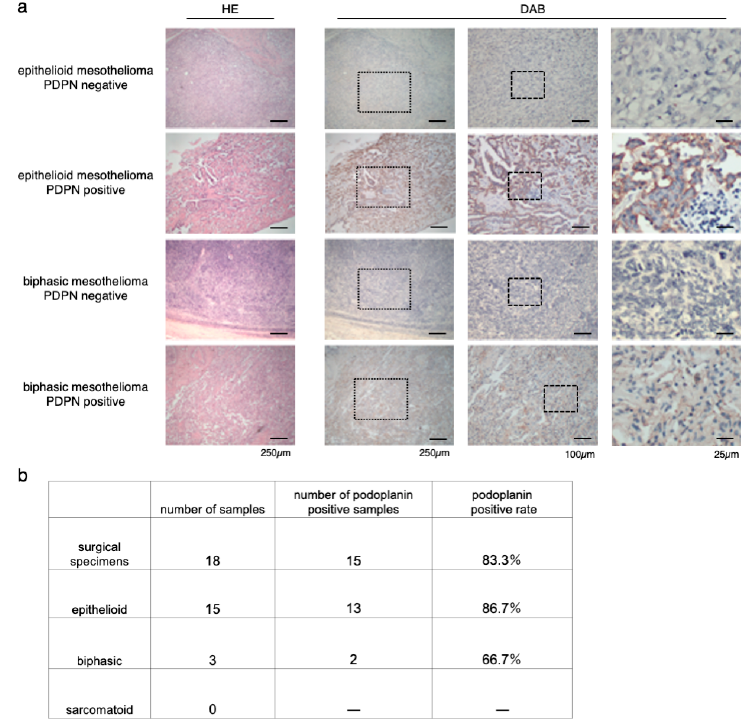
Figure 1. Immunostaining of surgical specimens of human resected MPM (malignant pleural mesothelioma). ( a ) Hematoxylin-eosin (HE) and podoplanin (PDPN) staining of epithelioid and